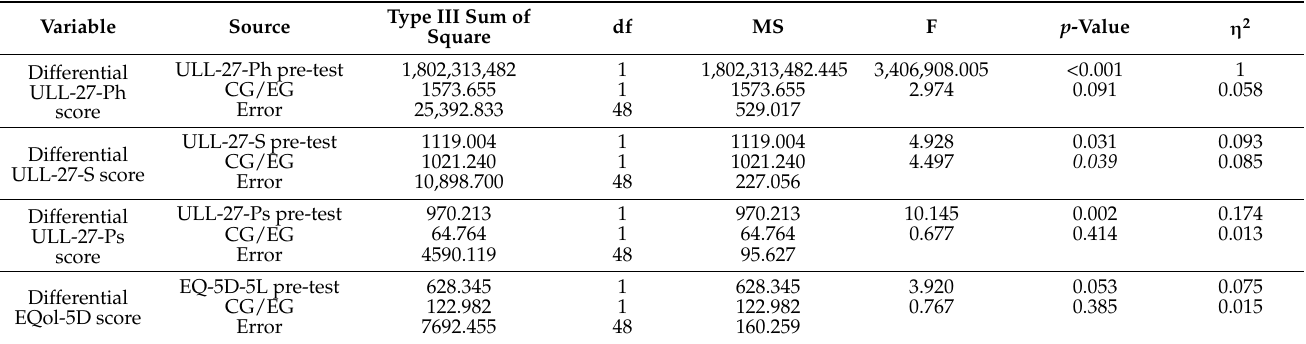
Table 3. Comparison between groups in differential (post-test − pre-test ) ULL-27 and EQol-5D scores, controlling pre-test scores, using ANCOVA.